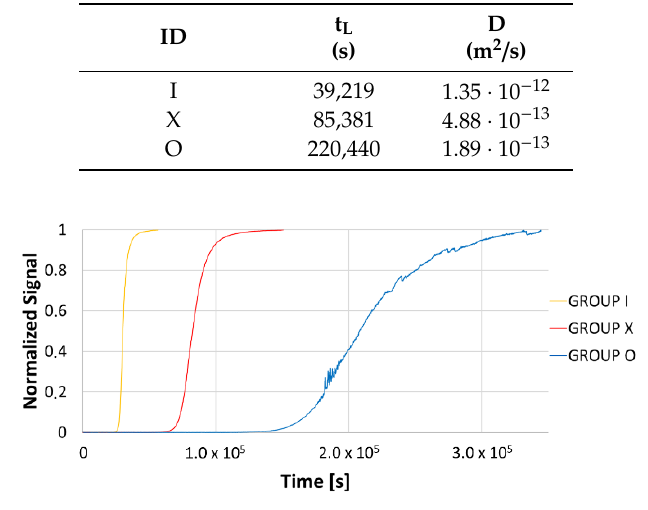
Table 3. Permeation test results for the steels under investigation.